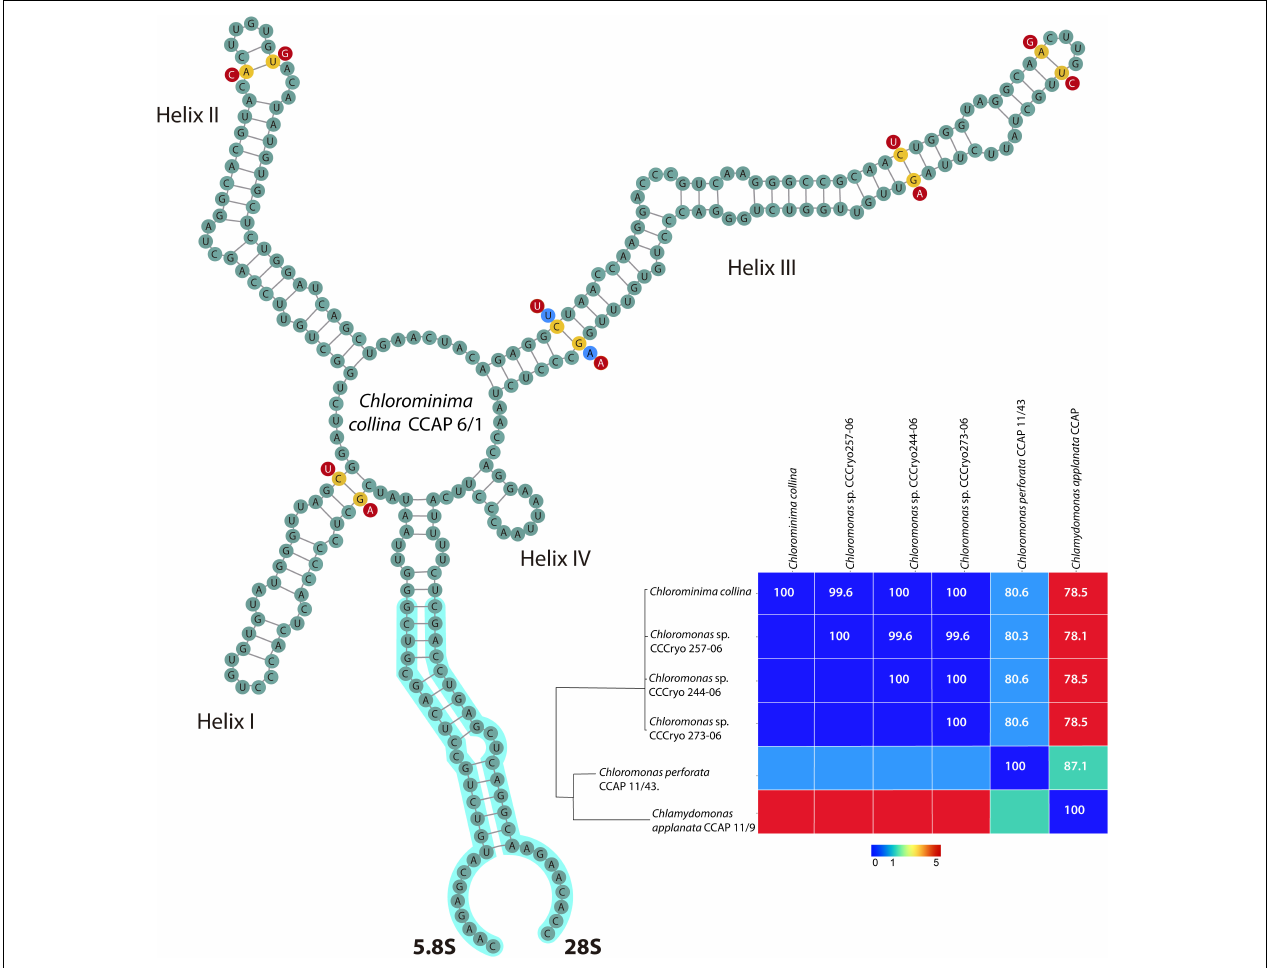
FIGURE 6 | Secondary structure model of the ITS2 rDNA of Chlorominima collina CCAP 6/1. The positions of CBC are shown in yellow circles between Chlorominima collina and Chloromonas perforata CCAP 11/43 (light blue circles) and Chlamydomonas applanata CCAP 11/9 (red circles). The Matrix under the structure shows compensatory base changes (CBCs) by color under diagonal and identity percent (above diagonal) among the respective strains considered for the analysis of the secondary structure of ITS2.